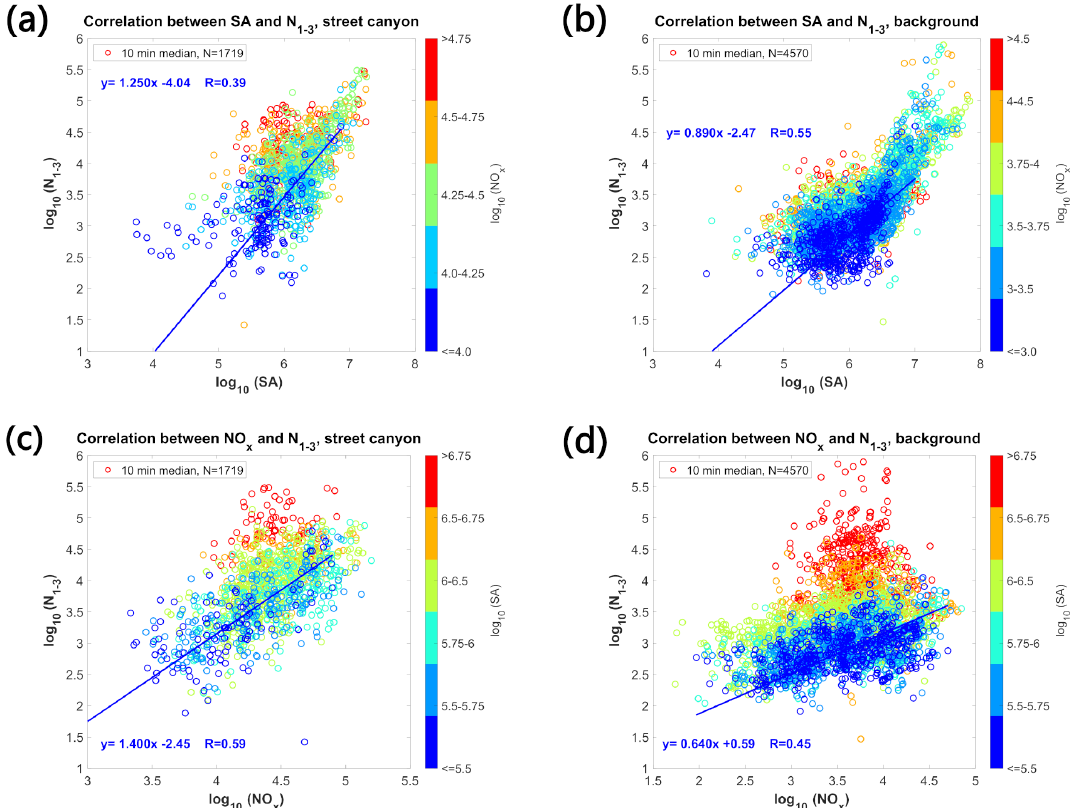
Figure 9. Correlation between the logarithm of SA and the logarithm of sub-3nm particles colored by the logarithm of NO x (a) at the street canyon and (b) at the background station, as well as the correlation between the logarithm of NO x and the logarithm of sub-3nm particles colored by the logarithm of SA (c) at the street canyon and (d) at the background station. Blue lines represent bivariate fit done to data with the logarithm of NO x smaller than 4 at street canyon site (a) or 3 at background station (b) or data with the logarithm of SA smaller than 5.5 at both stations (c, d) . The parameters of the fit are presented as an equation on the plot. Panels (c, d) have different limits of the x